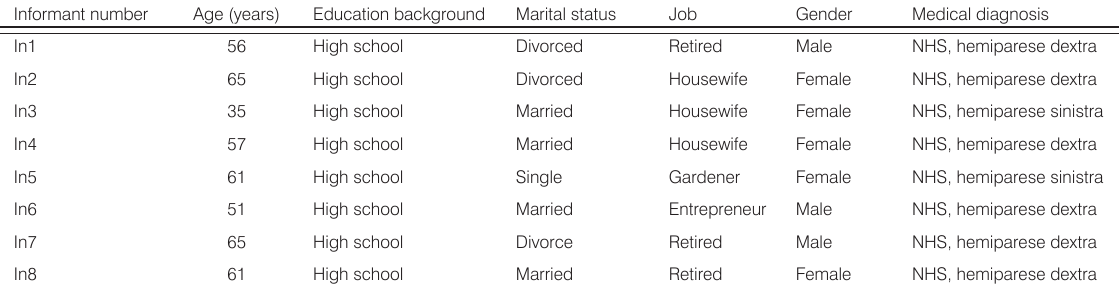
Table 1. Informant characteristics.